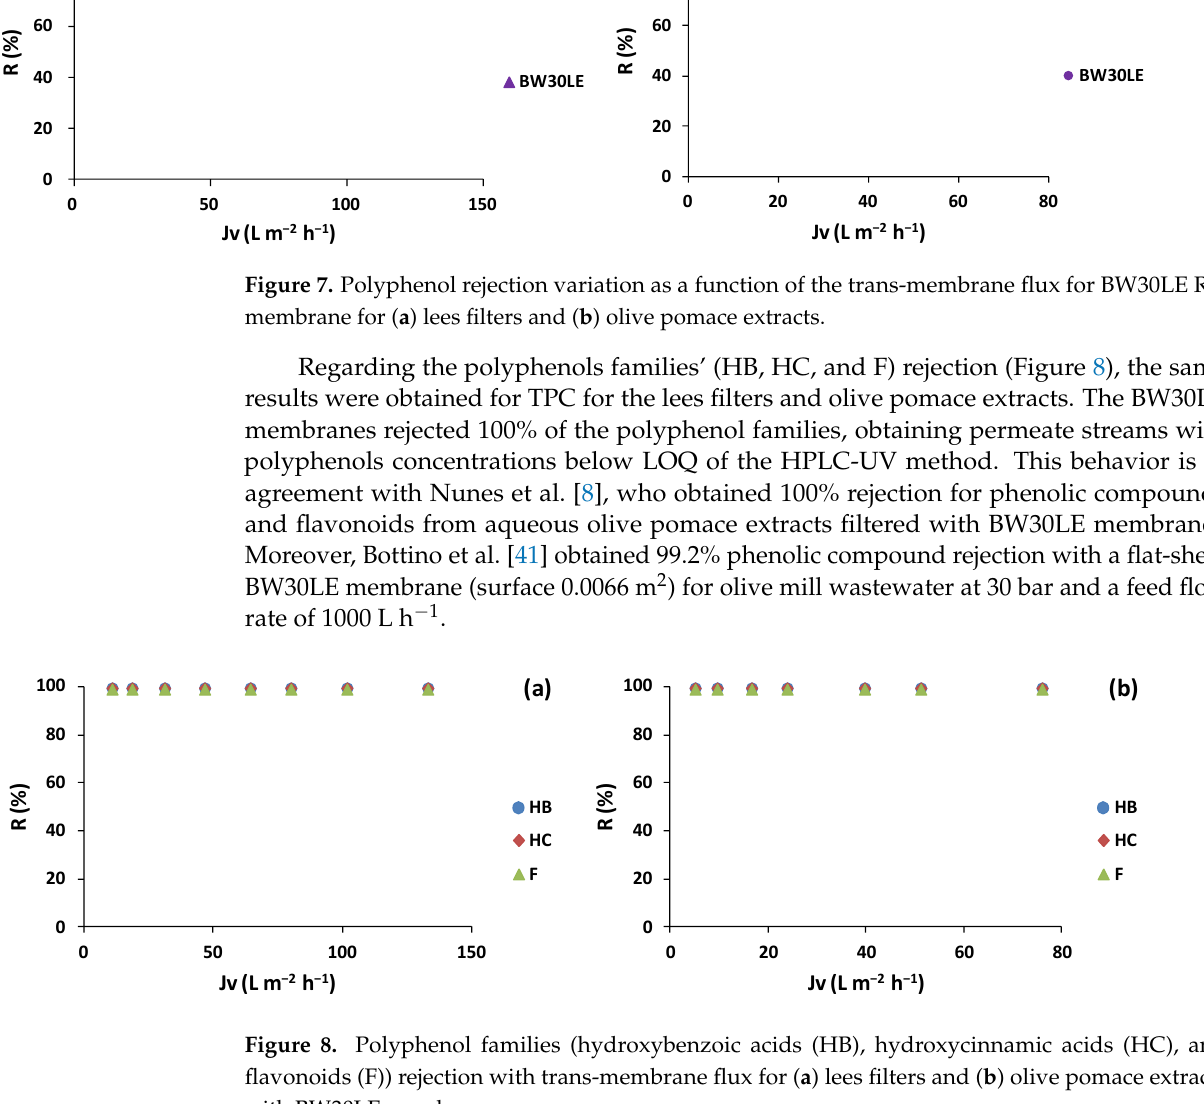
11 of 15 Figure 6. Trans-membrane flux variation as a function of the trans-membrane pressure for BW20LE